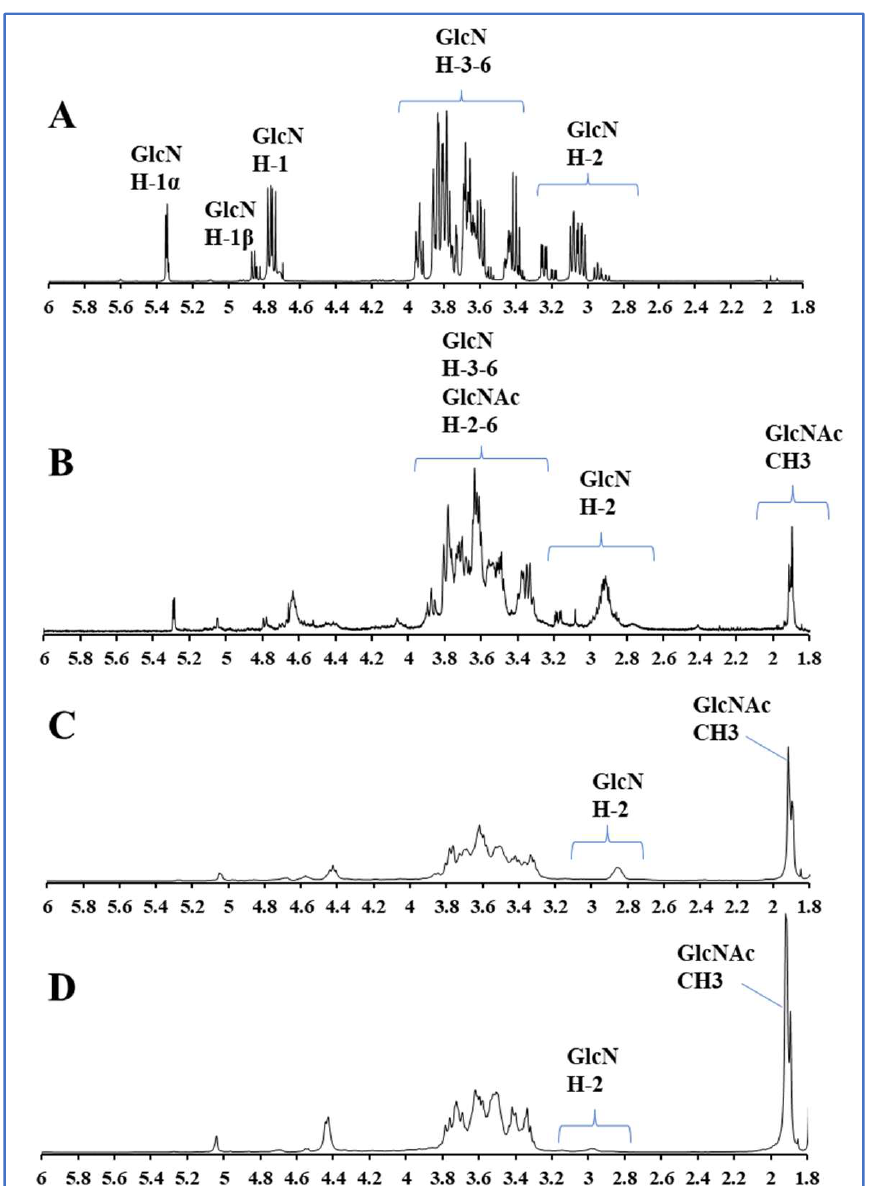
Figure 1. 1 H NMR spectra of COSs with different DAs. ( A – D ) represent 0% COS, 12% COS, 50% COS and 85% COS, respectively. The peak at 2.8–3.2 ppm is the hydrogen on the second carbon of GlcN, and the peak at 1.9 ppm is the hydrogen on the acetyl group in GlcNAc. The peak intensity at 1.9 ppm increases linearly with DA increasing.